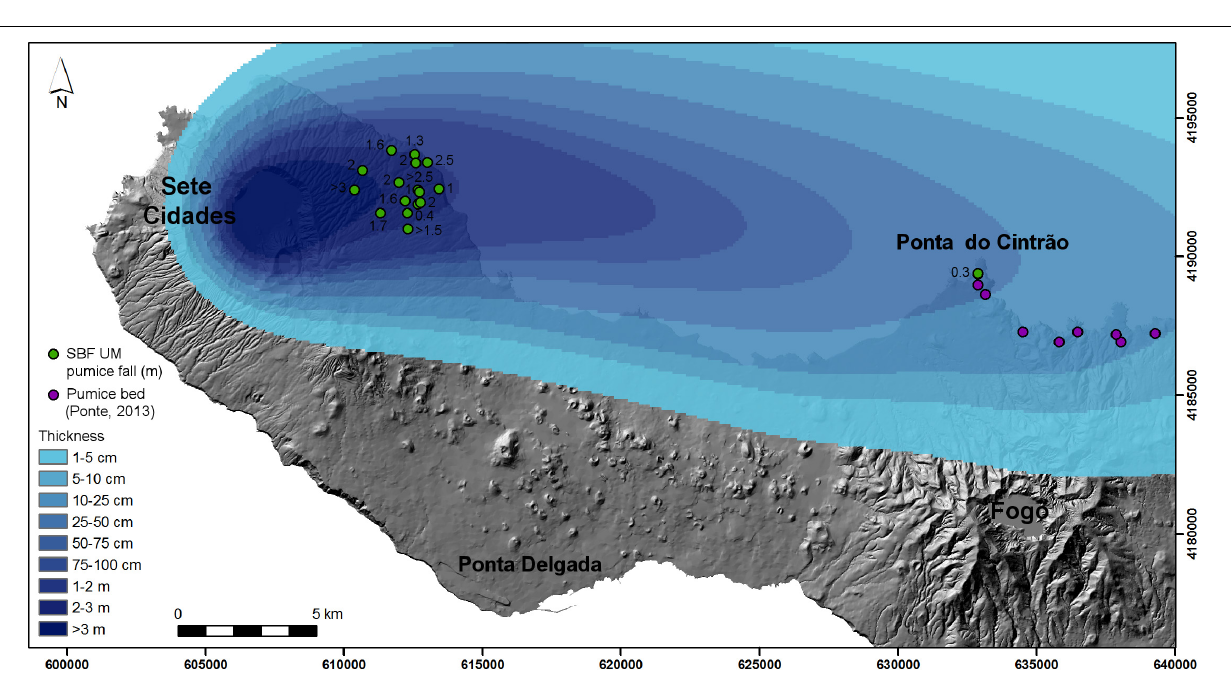
FIGURE 7 | Scenario 2 tephra fall map resulting from the simulations with VORIS 2.0.1, reconstructing the distribution of the proximal and mid-distal pumice fall deposit of the Upper Member of the SBF. Complex wind profile blowing from SW at lower altitude and from WNW at higher altitude are interpreted to be responsible for the deposition along the north coast of São